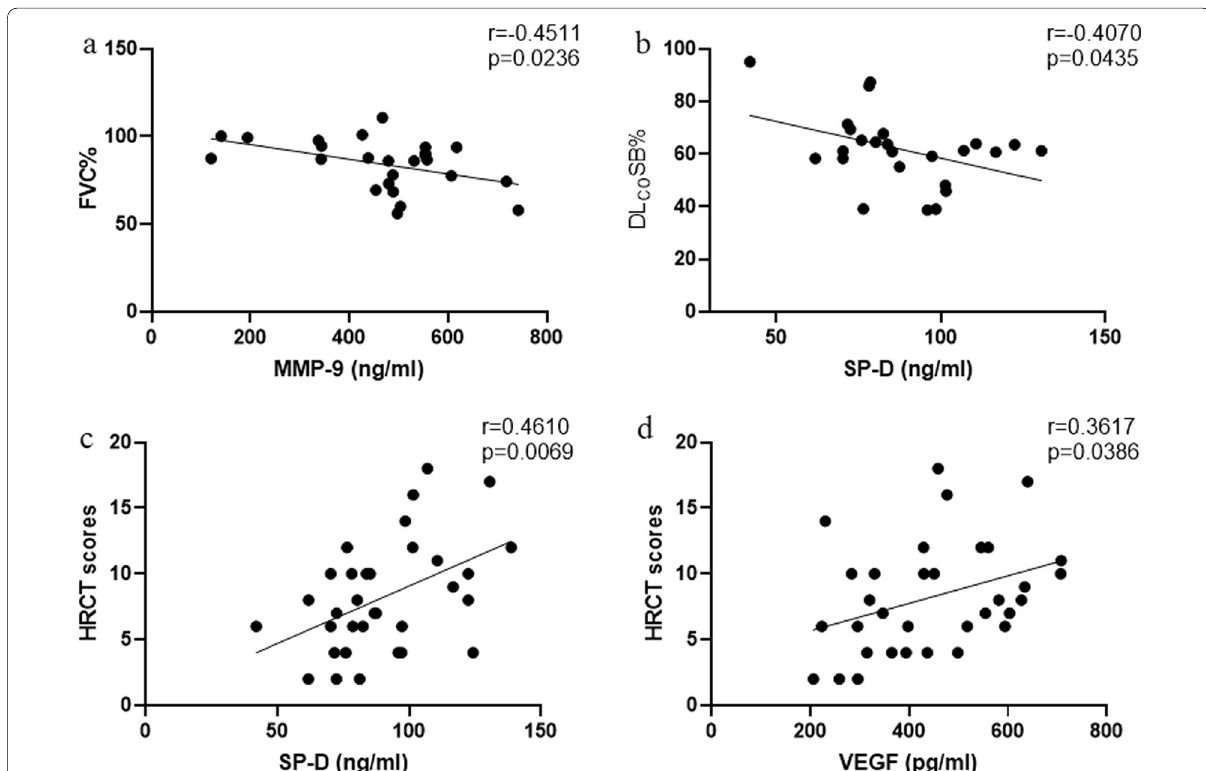
Fig. 4 a The correlation between serum MMP-9 level and FVC; b the correlation between serum SP-D level and DLco; c the correlation between serum SP-D level and semiquantitative HRCT scores; d the correlation between serum VEGF level and semiquantitative HRCT scores